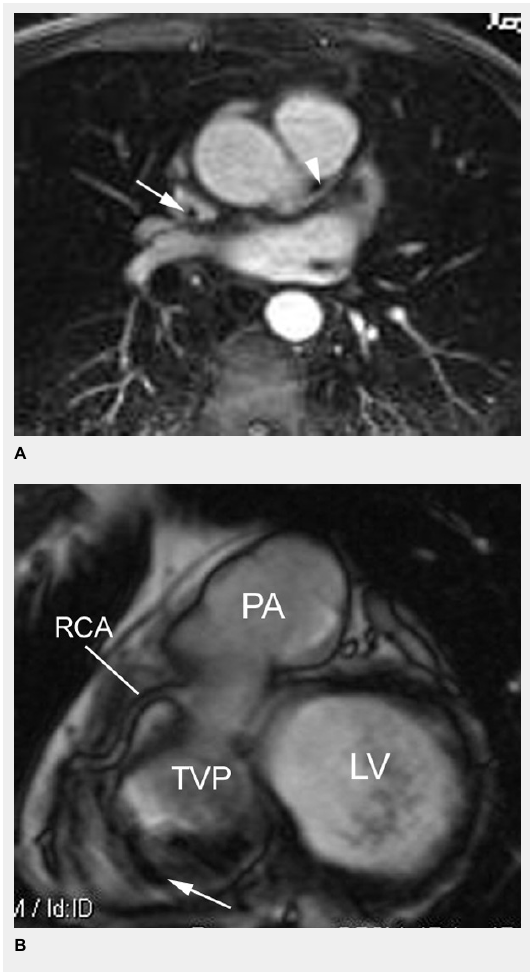
A Axial post-contrast MR image in patient with an MRI SureScan pacemaker. All anatomical details including left atrial appendage, left pulmonary vein and the main stem of the left coronary artery (arrowhead) are visualised well. The lead of the pacemaker causes only a small artifact (arrow). B MR image in short-axis view in a patient with a SureScan pacemaker. The proximal portion of the right ventricle is well visualised. The pacemaker lead creates an artifact at the posterior aspect of the tricuspid valve annulus (arrow). RCA = right coronary artery; PA = pulmonary artery; TVP = tricuspid-valve plane; LV = left ventricle. (images courtesy of Prof. J. Schwitter, CHUV,